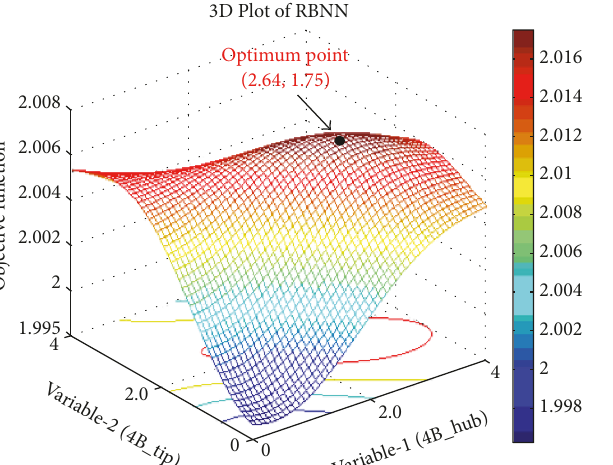
Figure 5: 3D surface plot for the RBNN model.